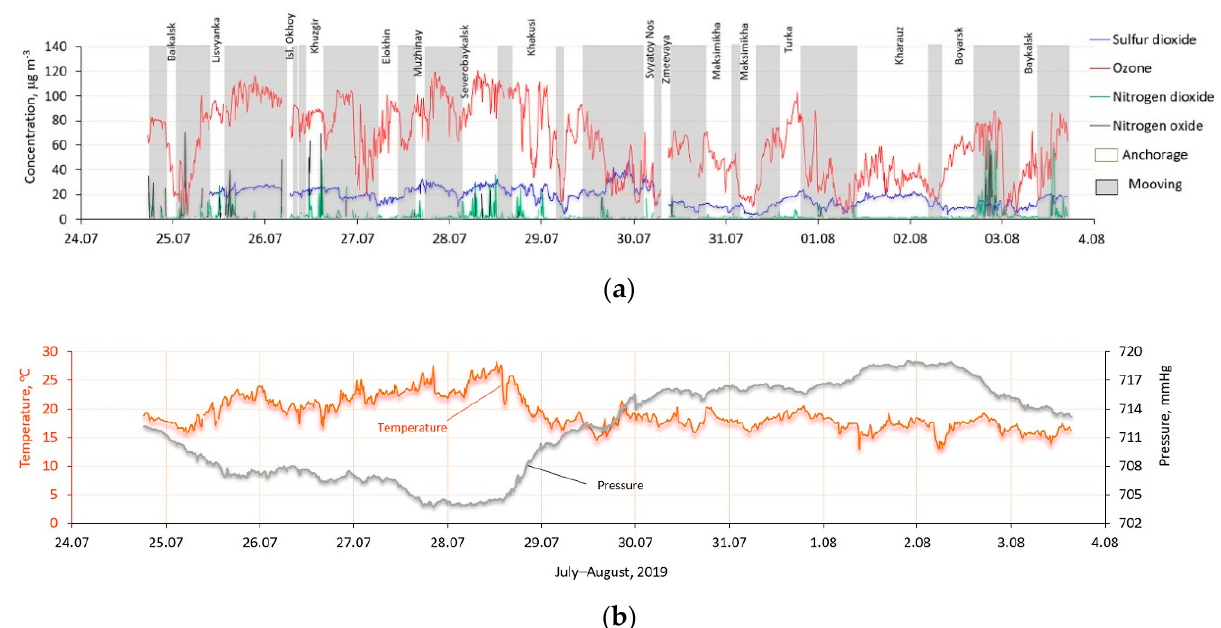
Figure 4. The spatial—temporal variability along route of the research vessel “Akademik V.A. Koptyug”: ( a ) round-level of ozone, nitrogen dioxide and sulfur dioxide concentrations; ( b ) temperature,